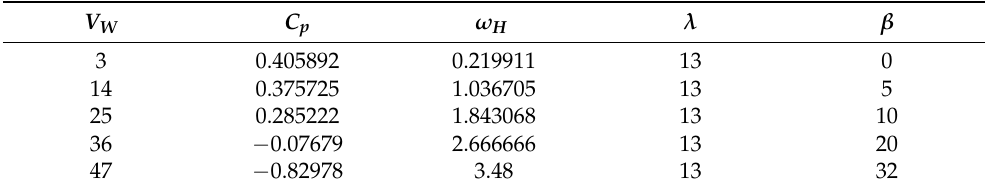
Table 5. Wind speed and angular speed of the wind turbine rotor based on the 32 degrees pitch angle adjustment.